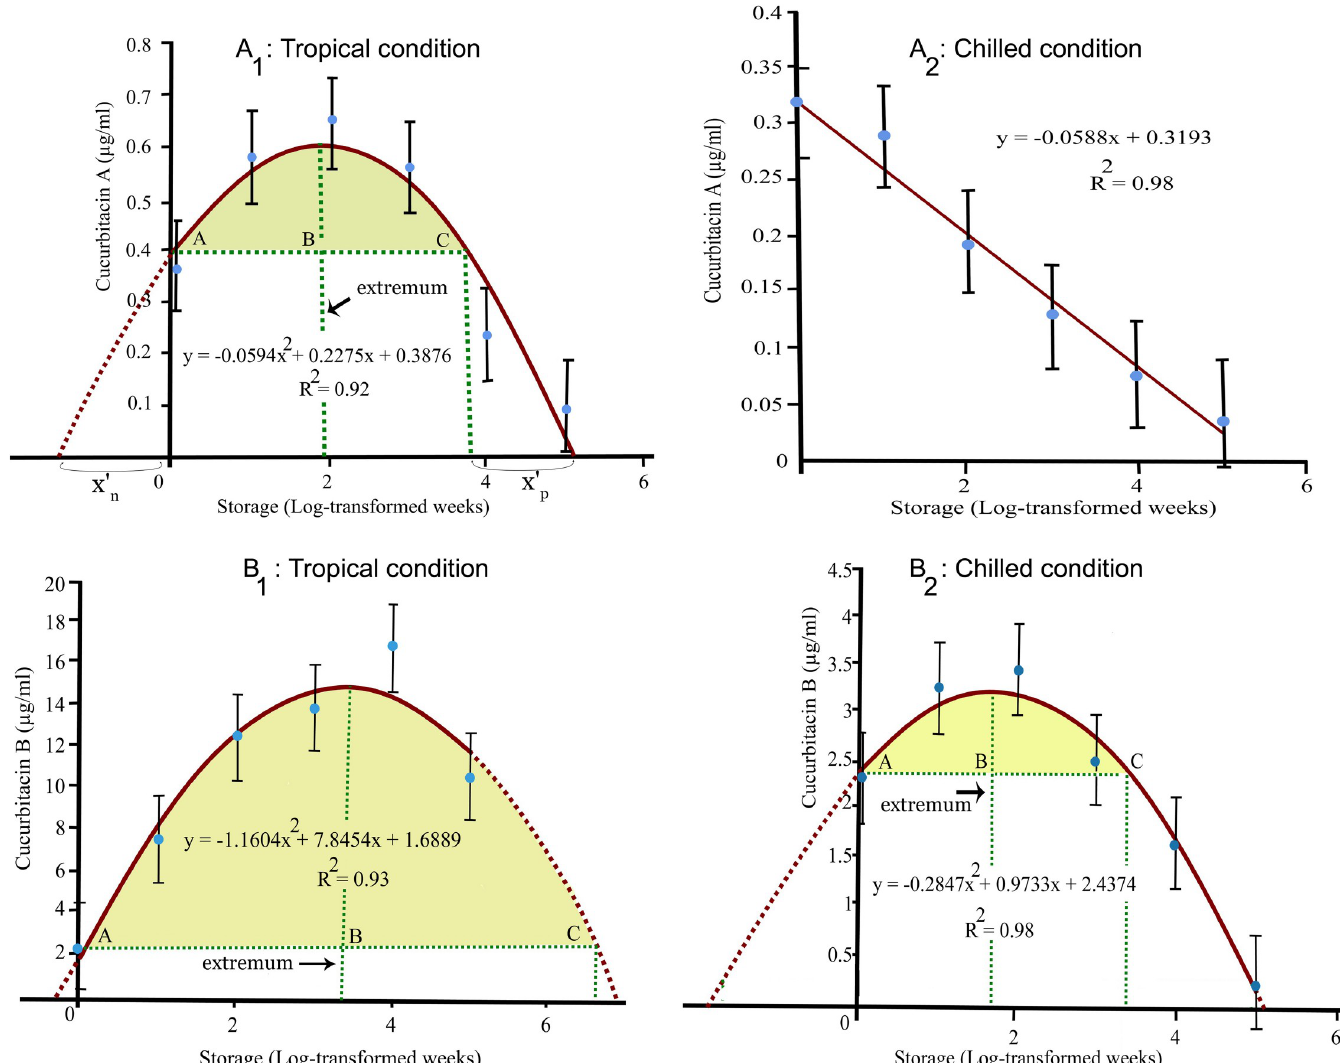
Fig 2. Quadratic models for cucurbitacins in phytonematicides stored under tropical and chilled conditions: Cucurbitacin A and B under tropical (A 1 , B 1 ) and chilled (A 2 , B 2 ) conditions, with dotted lines on parabolic curves to enhance symmetry, vertical line being the extremum ( ½ parabola), dotted horizontal line parallel to axis representing shelf-life of cucurbitacin-phytonematicide.